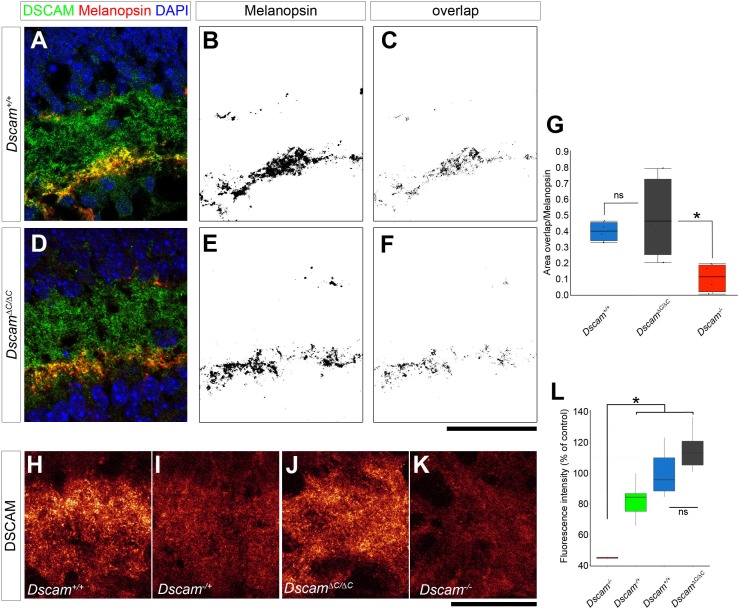
DSCAM protein localization is grossly unchanged in Dscam∆C/∆C retinas.(A–F) Confocal images of P9 retinas immunolabeled for DSCAM and melanopsin show normal colocalization between the proteins in control (A–C) Dscam∆C/∆C animals (D–F). The colocalization is quantified in G. N = 4 retinas per genotype. *p<0.05. (H–L) Confocal images of P7 retinas immunolabeled for DSCAM collected under standardized microscope settings from Dscam+/+ (H), Dscam-/+ (I), Dscam∆C/∆C (J), and Dscam-/- (K) retinas show the relative staining intensities in each mouse. (L) Intensities were measured along a 10 µm line adjacent and perpendicular to the INL, a region that includes S1. Fluorescence intensity in Dscam∆C/∆C retinas was not reduced. Box plots represent the median, first and third quartile, range, and outliers. N = 6 retinas each for Dscam+/+, Dscam-/+, and Dscam∆C/∆C genotypes and 2 retinas for Dscam-/-. *p<0.05.